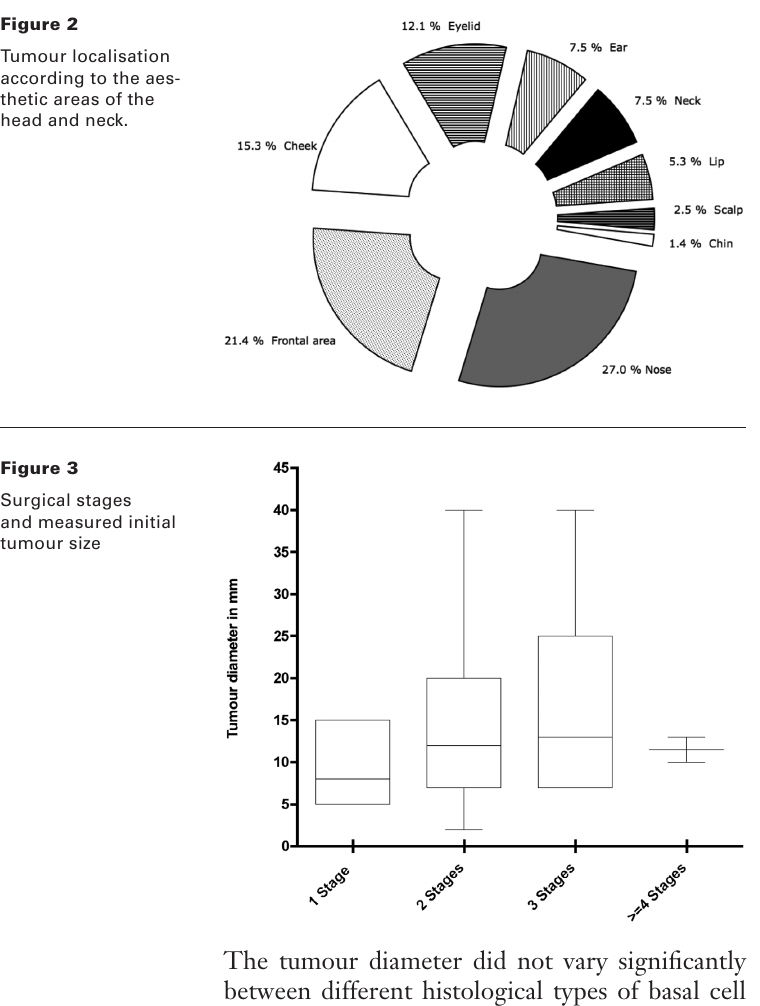
Tumour localisation according to the aes- thetic areas of the head and neck.